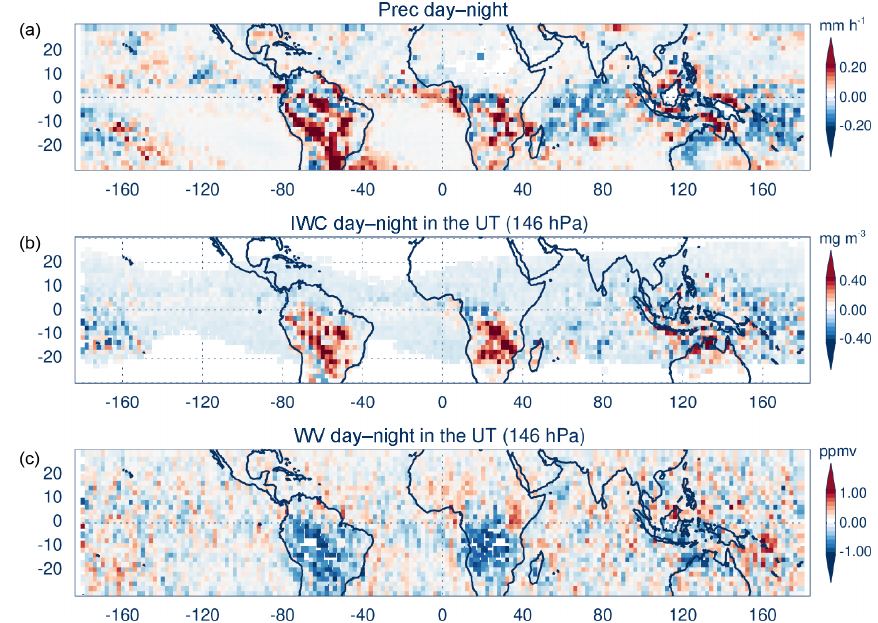
Figure 7. Day − night of (a) precipitation (Prec) from the TRMM, (b) ice water content (IWC) from the MLS at 146hPa, and (c) water vapour (WV) from the MLS at 146hPa over the tropics and the period 2004–2017 in